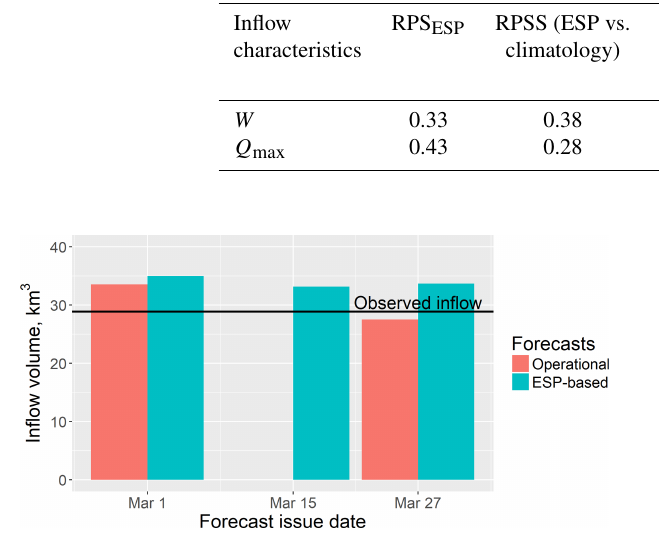
Table 3. Ranked probability score and skill score for the forecasts.